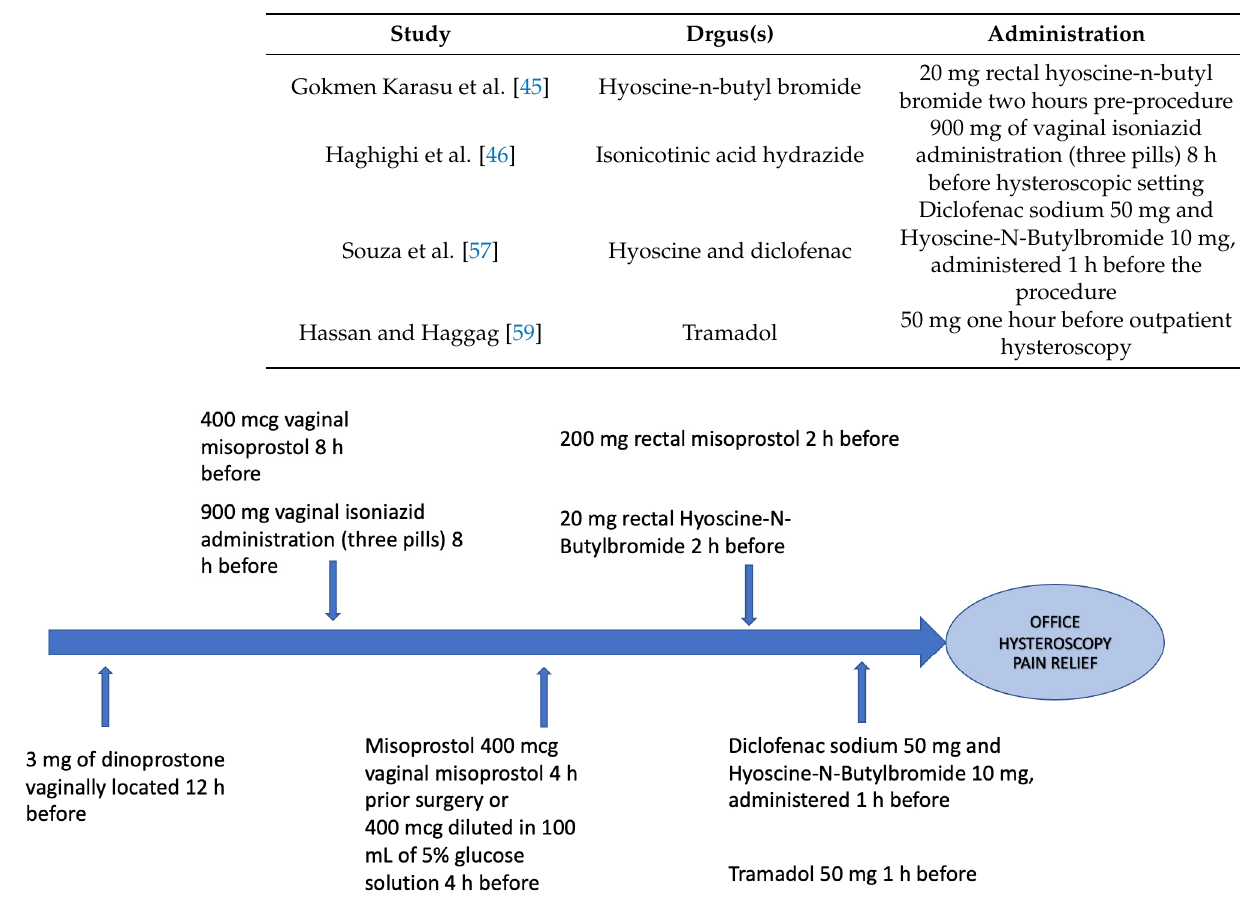
Figure 1. Summary of available pharmacological strategies for pain relief before office hysteroscopy. Table 2. Non-pharmacological strategies for pain relief in office hysteroscopy Table 1. Pharmacological strategies for pain relief in office hysteroscopy setting.